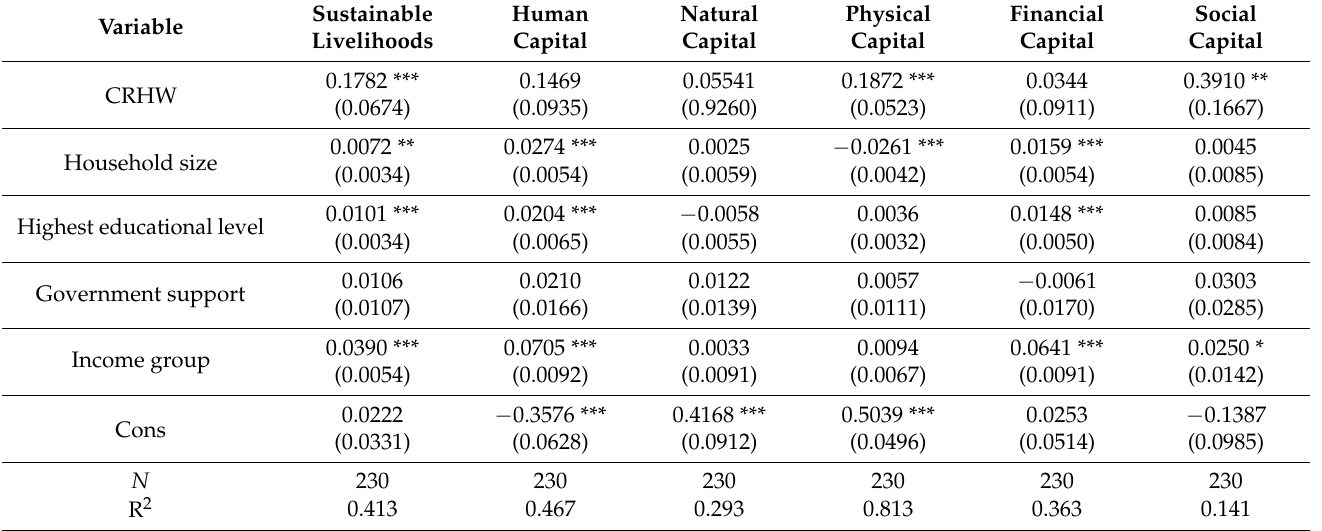
Table 2. Impact of the CRHW on sustainable livelihoods and livelihood